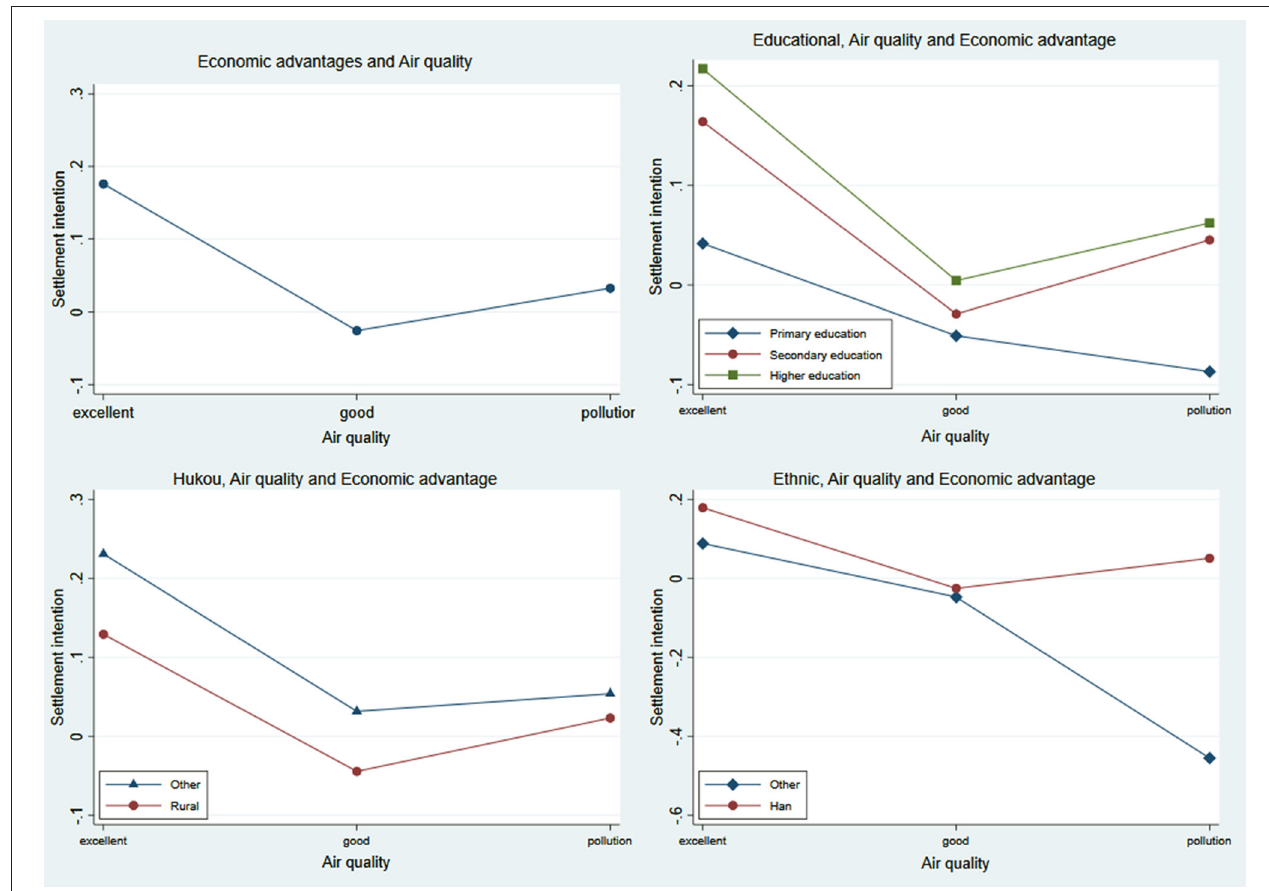
FIGURE 1 | The interactive effects of air quality and economic advantages on settlement intention of